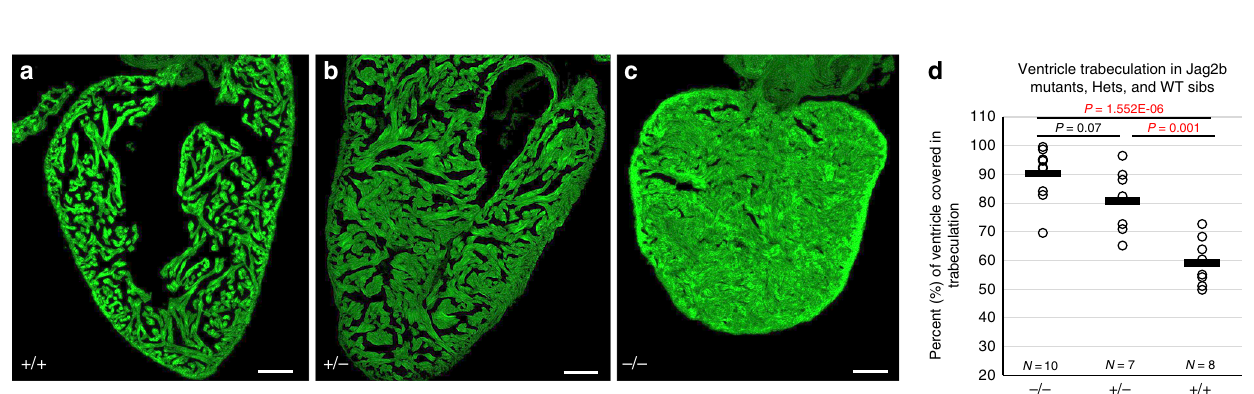
Fig. 4 Ablation of embryonic NC-Cms results in adult-onset hypertrophic cardiomyopathy and heart failure. a – c Whole-mount fl uorescent images of adult hearts from embryonic NC-Cms ablation experiments (protocol in Fig. 2a). Red numbers represent percent of NC-Cms relative to total cardiomyocytes (GFP + and RFP + ), not total heart cells, quanti fi ed by fl ow cytometry (FACS) of dissociated adult hearts (Supplementary Figure 9). d FACS quanti fi cation of NC-Cms. Dots are individual hearts from each condition and bars = mean of individuals in each group ( n = 4 + RE + GFP, DMSO and n = 5 + RE + GFP, MTZ) e – g Fluorescent microscopy sections of hearts from sibling individuals as in A-C. scale bar = 100 µ m. h Quanti fi cation of area of ventricle covered in cardiomyocytes from sections similar to d – f . Dots represent sibling individuals from each condition pooled from biological replicates. Solid line = median, dashed line = mean. P -values computed by TukeyHSD on ANOVA (F(2,16) = 9.48). i-j Examples of single-cell cardiomyocyte morphology from dissociated control ( i ) and NC-Cm-ablated adult ventricles. Cells were cultured in chambers for 24 h to allow cell attachment, then fi xed and stained with anti-GFP and DAPI and visualized by microscopy. Scale bar = 10 µ m. k Quanti fi cation of individual cardiomyocyte area from chamber cultures as in “ i , j ” ; n ≥ 25 cells per sample. P-value from standard T test. l Quanti fi cation of individual cardiomyocyte lengths from chamber cultures as in “ i , j ” . P -value from standard T test. m Example still image from movies of swim tunnel assays of individual male zebra fi sh. Red arrow indicates water current direction. n Swim trial assay provided incremental water speed increases of 0.05 m/s every 6 min (solid black line). Average assay results for DMSO control (light green, n =